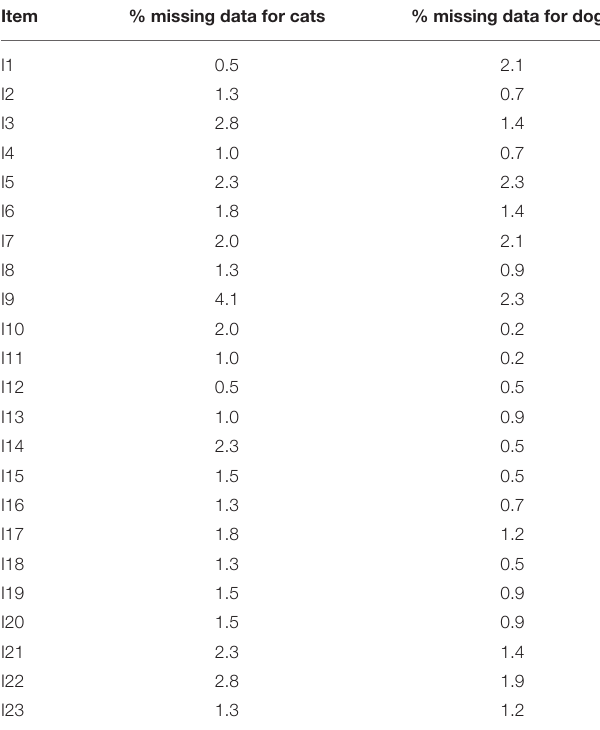
TABLE 6 | Missing data for items. TABLE 7 | Corrected item-total correlations for cat and dog owner